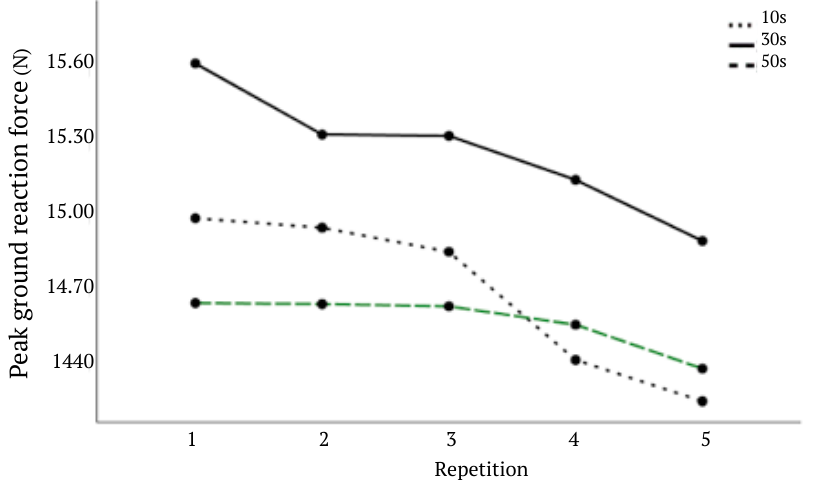
Figure 3. Peak GRF at each repetition from different